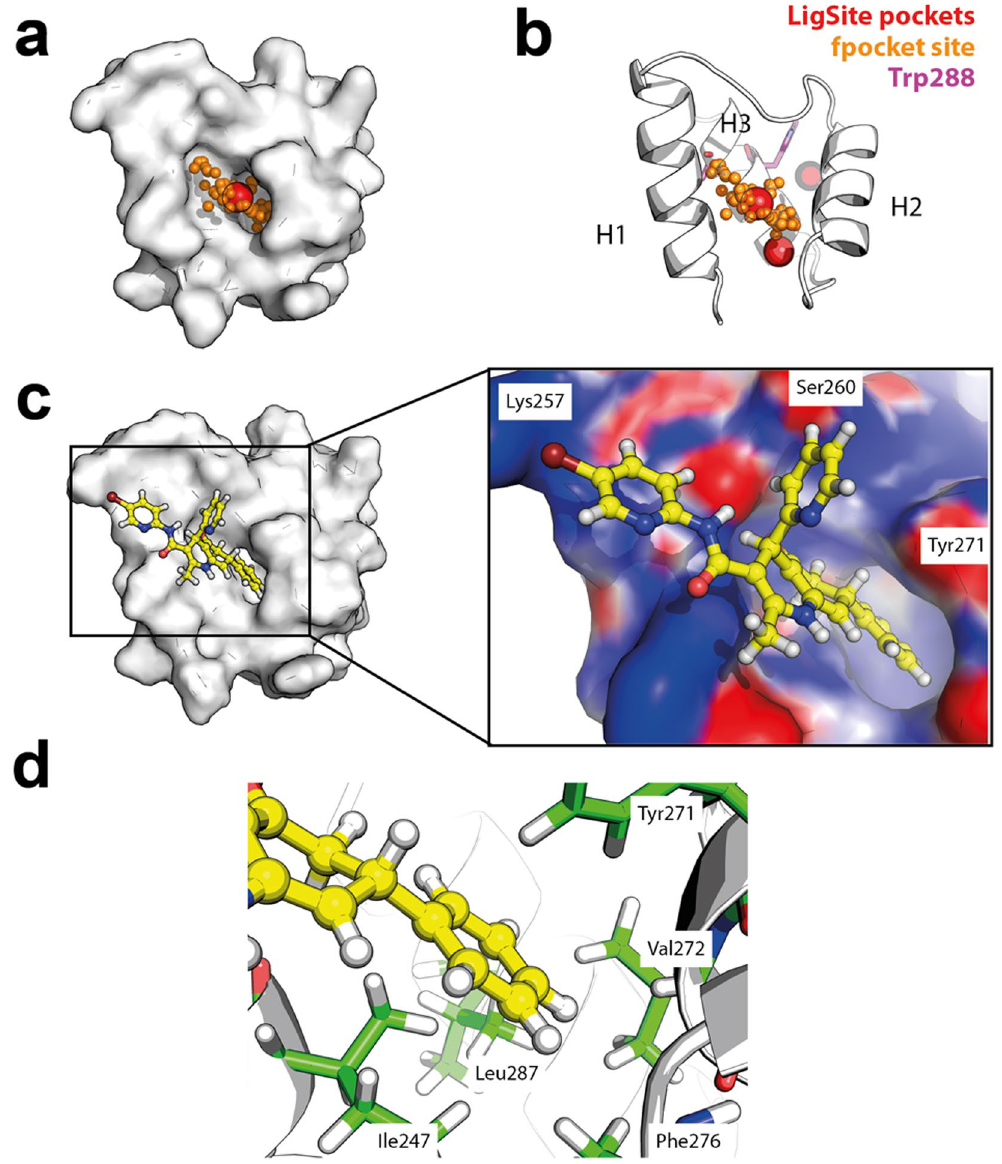
Figure 4. Prediction of C1 binding to the C-terminal domain of NPM. Structure of the C-terminal domain of NPM (PDB ID: 2LLH) is shown in surface ( a ) and cartoon representation ( b ) with binding pockets predicted using fpocket (orange) and LigSite (red). Binding mode as predicted by computational protein-ligand docking ( c , d ) suggests that the aromatic phenyl ring of C1 occupies the hydrophobic pocket presented in ( a ), and also establishes favorable polar interactions with solvent accessible residues. A close-up view of C1 in the pocket is shown in ( c ), with the surface of the domain coloured according to electrostatic surface potential, with charge ranging from -3 kT/e (deep red) to 3 kT/e (deep